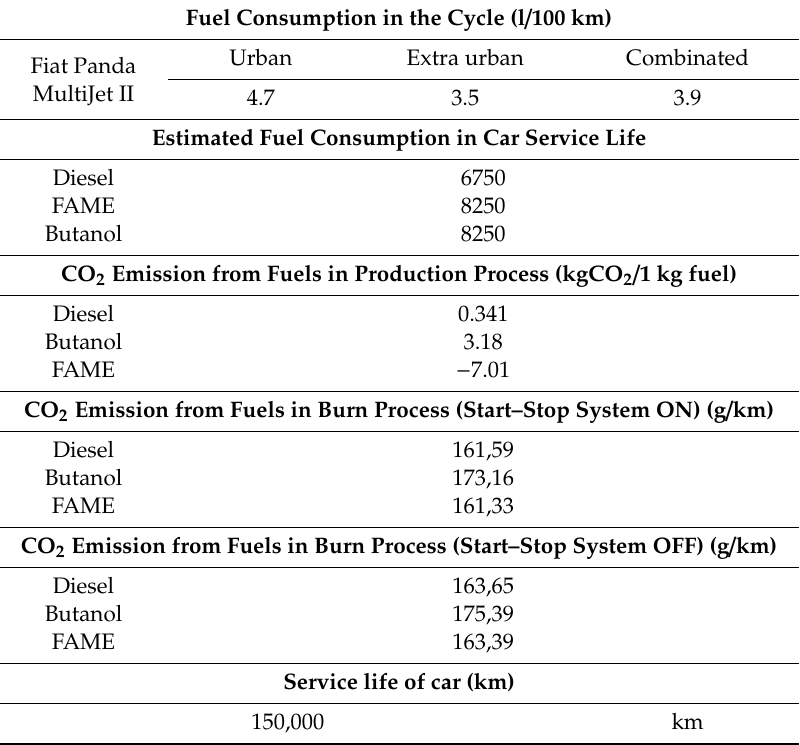
Table 6. Parameters used in LCA